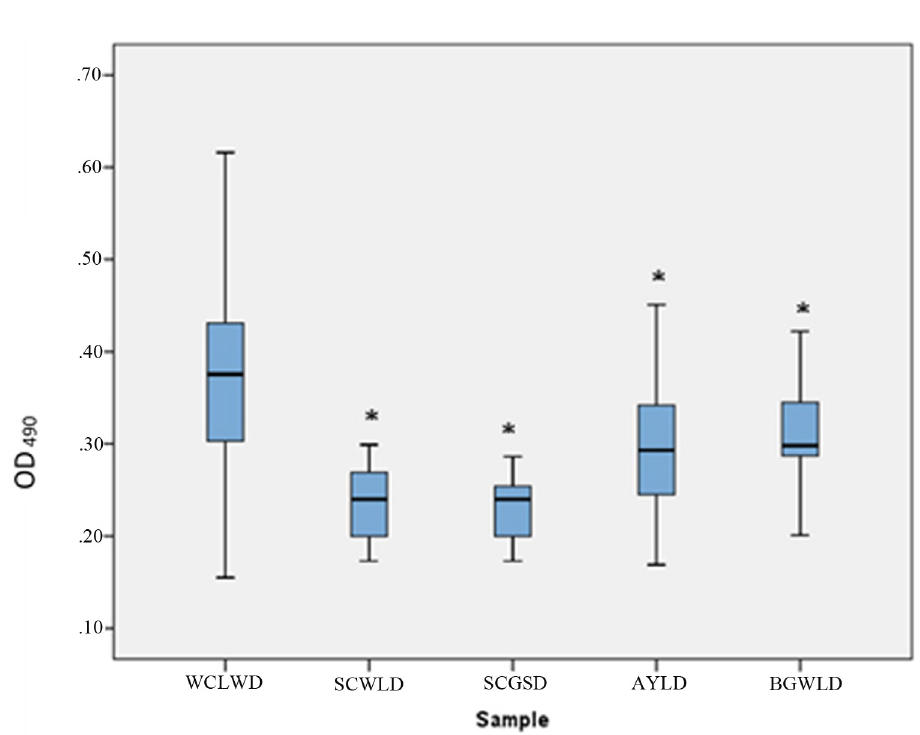
Fig 3. Indirect ELISA (OD 490 ) responses of sec A PCR positive (i) WCLWD infected coconut samples (N = 197), (ii) sugarcane leaf samples infected with SCWLD(N = 30) and (iii) SCGSD (N = 25), (iv) leaves of Areca palms infected with AYLD (N = 25) and (v) Bermuda grass infected with BGWLD (N = 35). Standard box-plots with median, 25th and 75th percentiles and whiskers at maximum and minimum values are indicated. ( � p < 0.05).